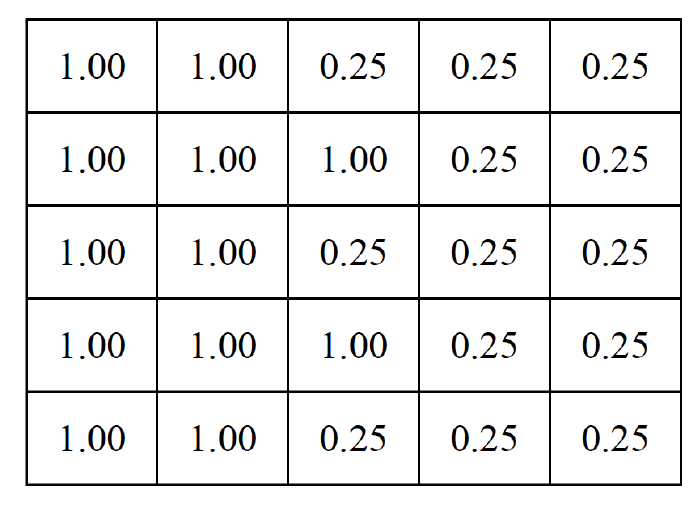
Figure 9. Radial power profile for the PSBT 5 × 5 rod